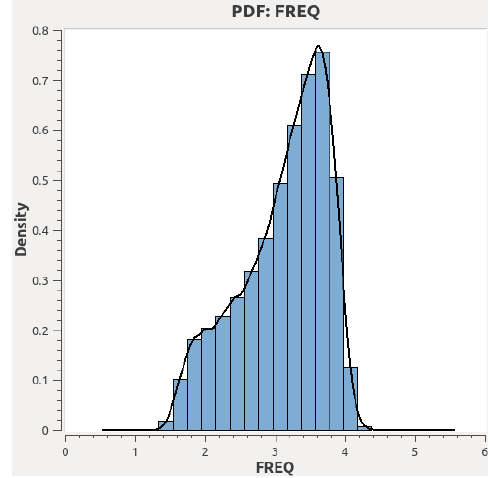
Figure 7. Frequency output distribution.